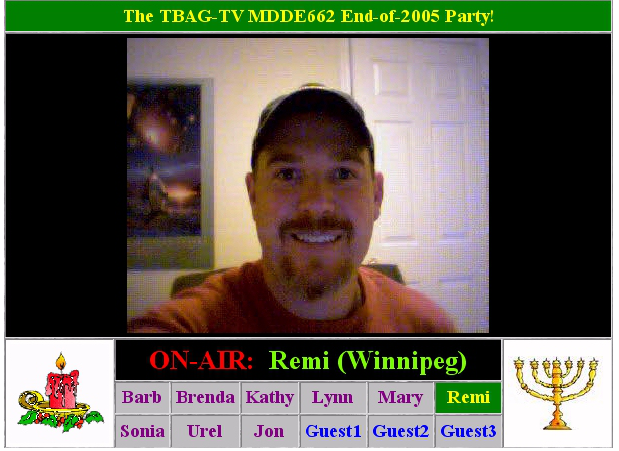
Figure 2. The selected image is pushed to participants on a ‘transmission